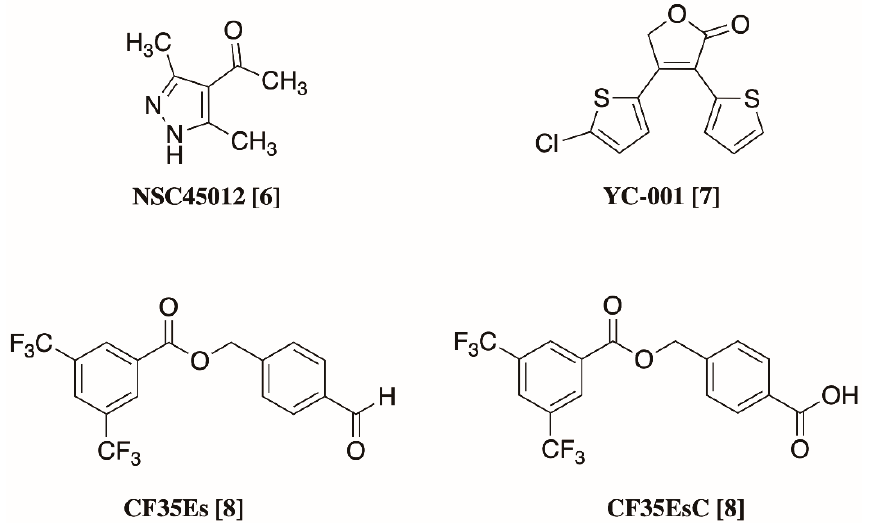
Figure 1. Chemical structures of non-retinoid small molecules previously reported for their ability to act as pharmacological chaperones for opsin [6–8].